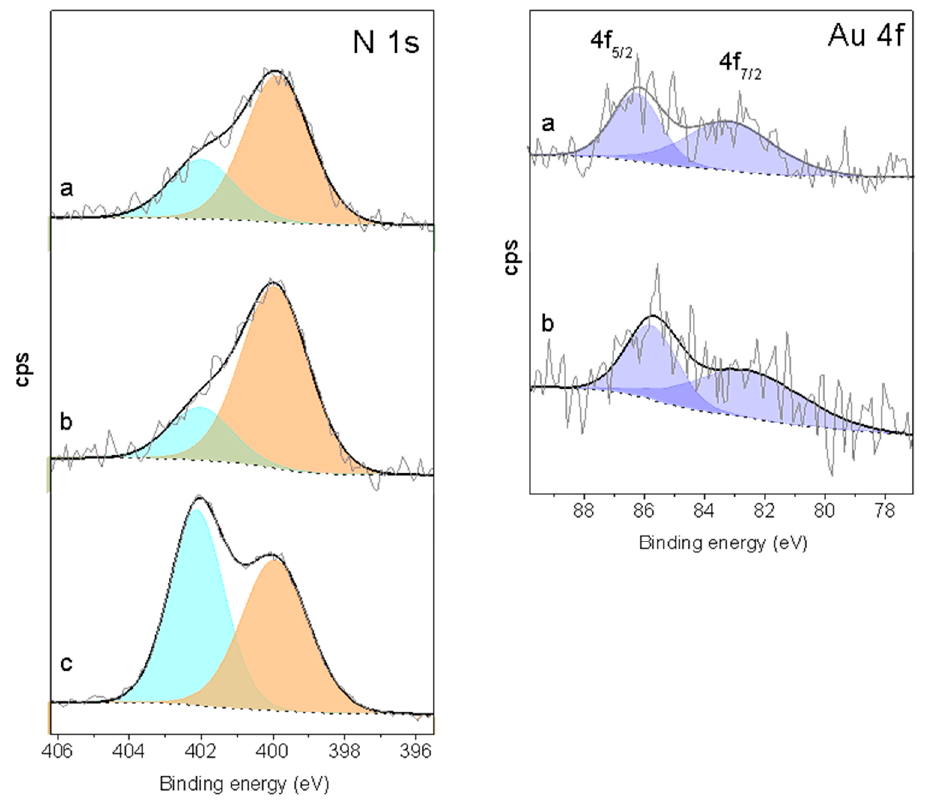
Figure 6. N 1s and Au 4f core-level spectra of samples ( a ) 0.20-Au-1d, ( b ) 0.20-Au-8d and ( c ) 0.20-E. Signal intensities have been normalized to a constant Si 2p peak area.